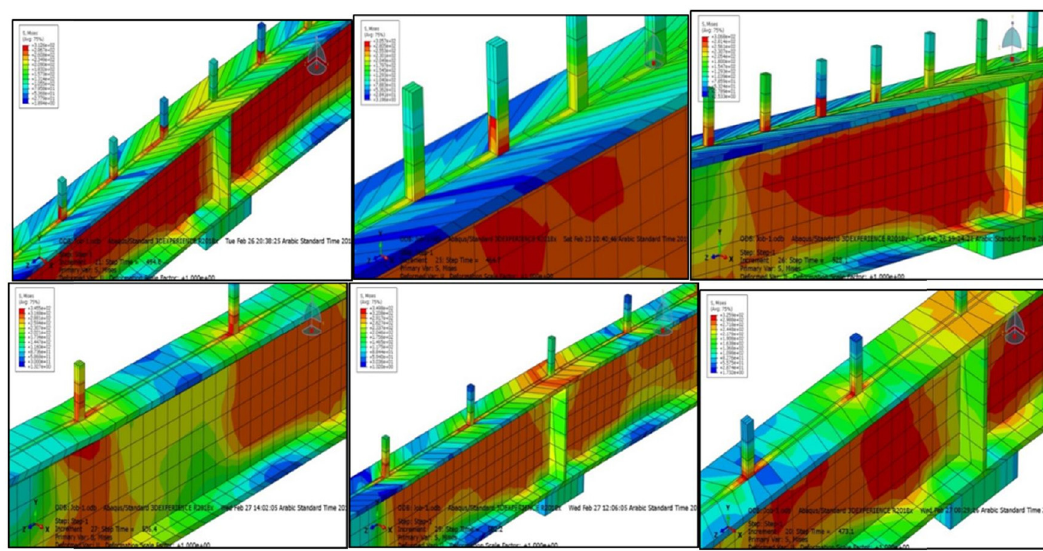
Figure 12: Stress distribution for specimens of Group B.